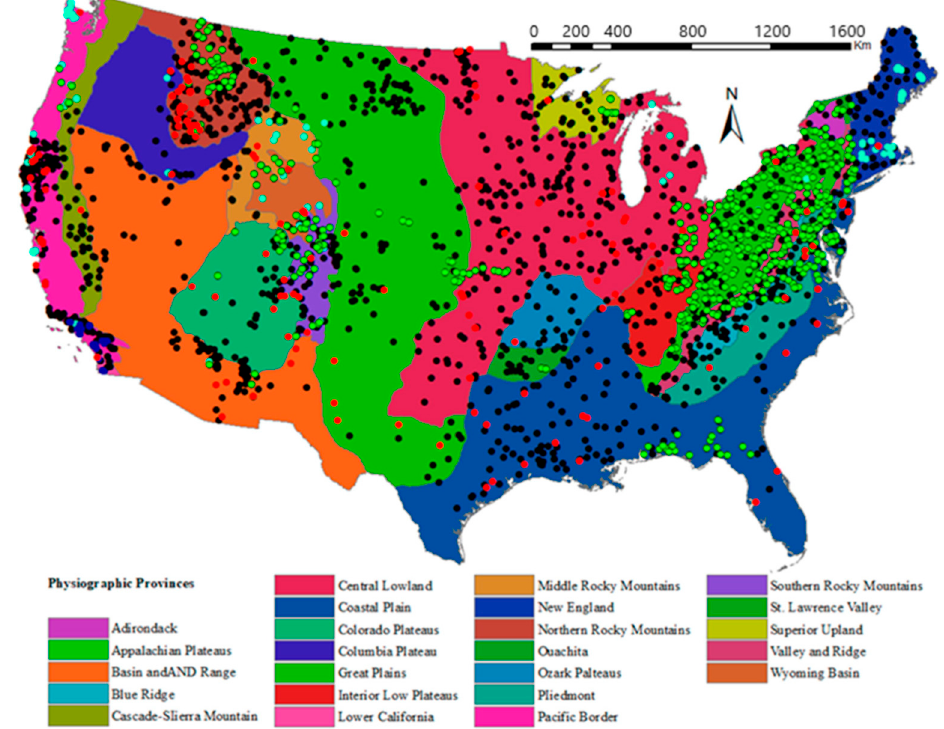
Figure 1. Distribution of data points over Physiographic Provinces adapted from Jha et al. [30]. Dots with different colors in the figure represent different D50 data sources.